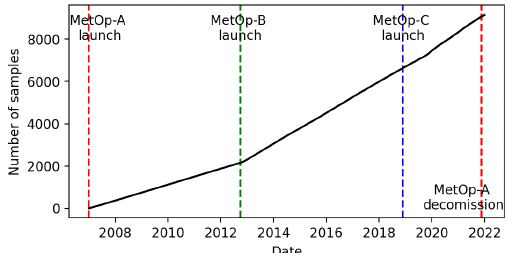
Figure 6. Cumulative number of samples of ASCAT observations at the FINO3 location from 2010–2022. The vertical lines represent the launch of each MetOp satellite as well as the decommission date of